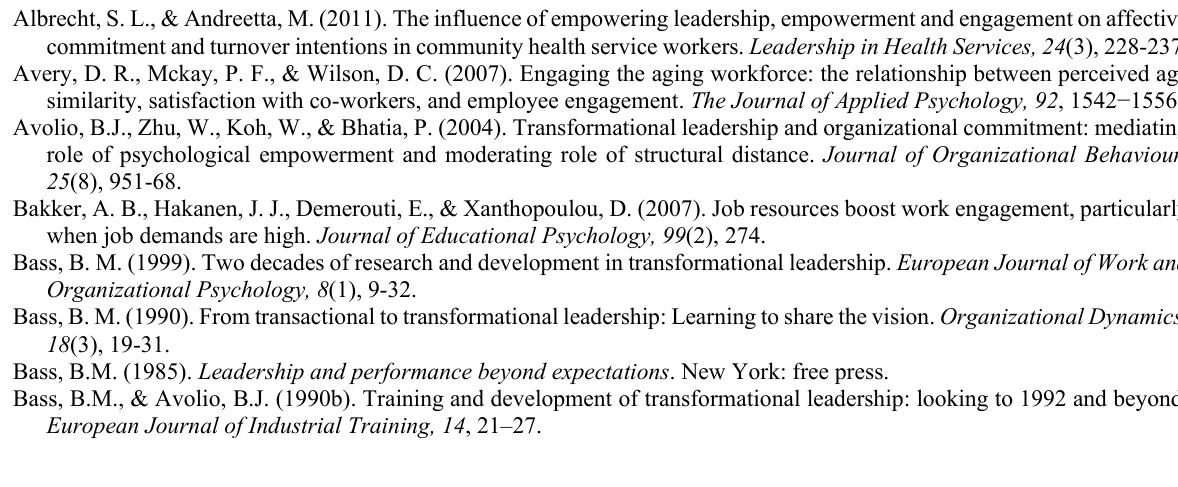
Table 2 indicated all indices to test the goodness of fit for the model are satisfactory. GFI, CFI and TLI are above 0.9. The root mean square error of approximation (RMSEA) has a value of 0.035. This index is bounded lower than 0.08 which indi- cated quite good). The goodness of fit result showed that the model fits the data quite well (Hair et al., 1998)